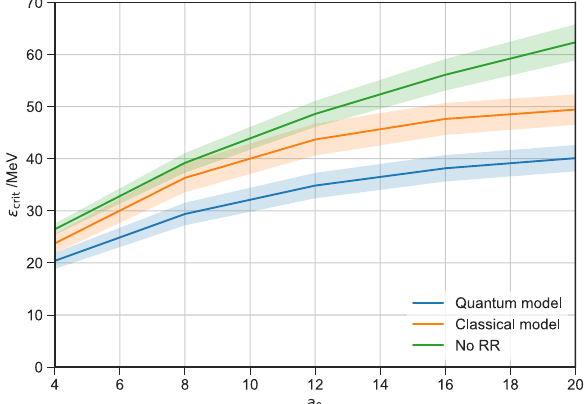
FIG. 8. Simulated retrievals of ε assuming the collision of a crit plane wave of given peak a 0 with the experimentally measured electron spectra. The shaded regions represent (cid:3) 1 σ variations arising from the measured electron beam spectral FIG. 7. The spectrum of ICS photons radiated by a single electron as simulated for various ε and a 0 for the three initial radiation reaction models described in the text.